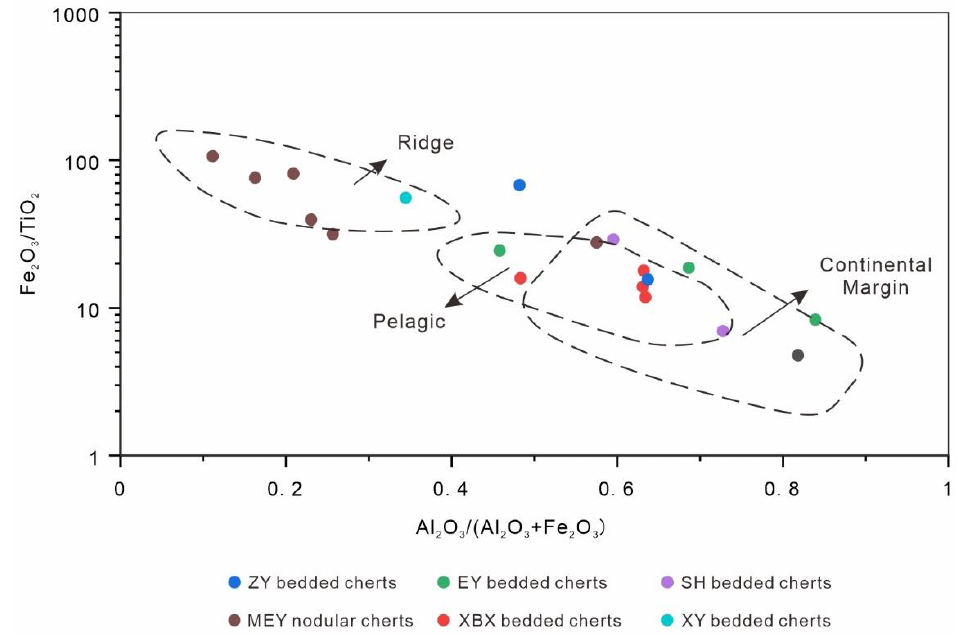
Figure 7. Fe 2 O 3 /TiO2 versus Al 2 O 3 /(Al 2 O 3 + Fe 2 O 3 ) diagram for the Maokou cherts in the Sichuan Basin.